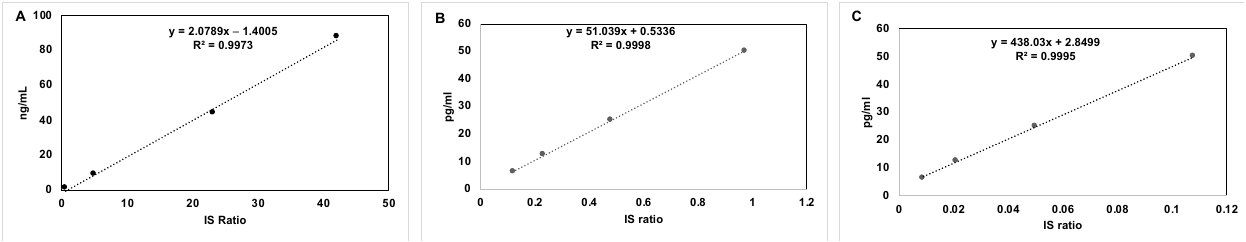
Figure 4. Calibration curve of D 3 metabolites; ( A ) 25(OH)D 3 ( 2 ); ( B ) 25(OH)D 3 -23,26-lactone ( 6 ); and ( C ) 1,25(OH) 2 D 3 -23,26-lactone ( 7 ).